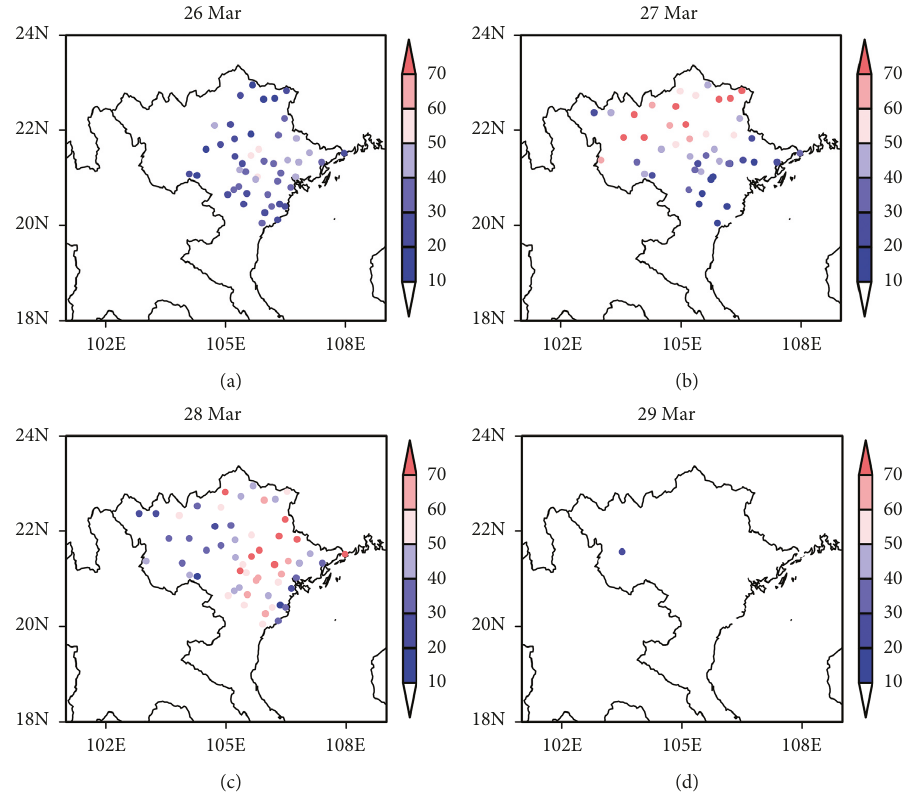
Figure 10: Same as Fig. 5, except for the period from 26 to 29 March